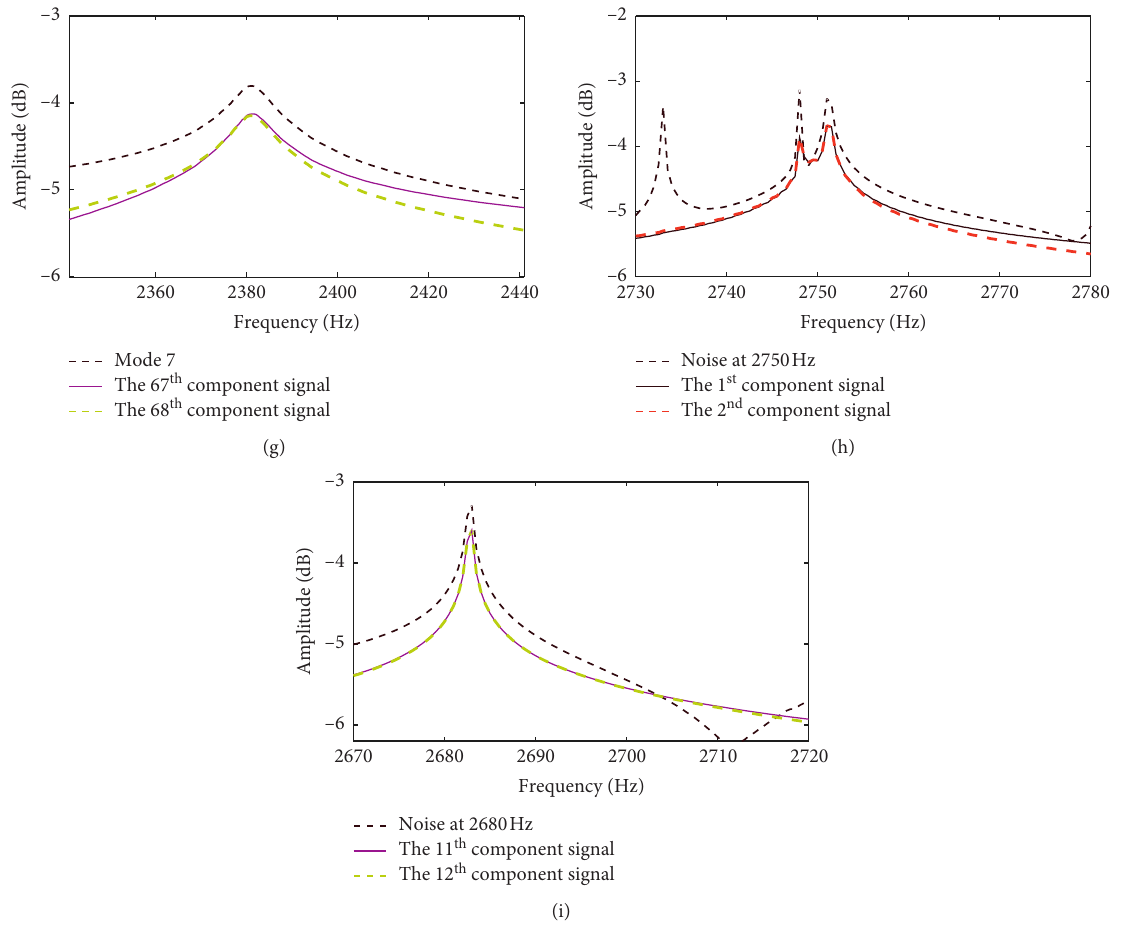
Figure 8: The modes and the corresponding component signals. (a) Component signals of mode 1 at 65Hz. (b) Component signals of mode 2 at 399 Hz. (c) Component signals of mode 3 at 428Hz. (d) Component signals of mode 4 at 1119Hz. (e) Component signals of modal 5 at 1334Hz. (f) Component signals of modal 6 at 2195Hz. (g) Component signals of mode 7 at 2381Hz. (h) Component signals of noise at 2750Hz. (i) Component signals of the noise at